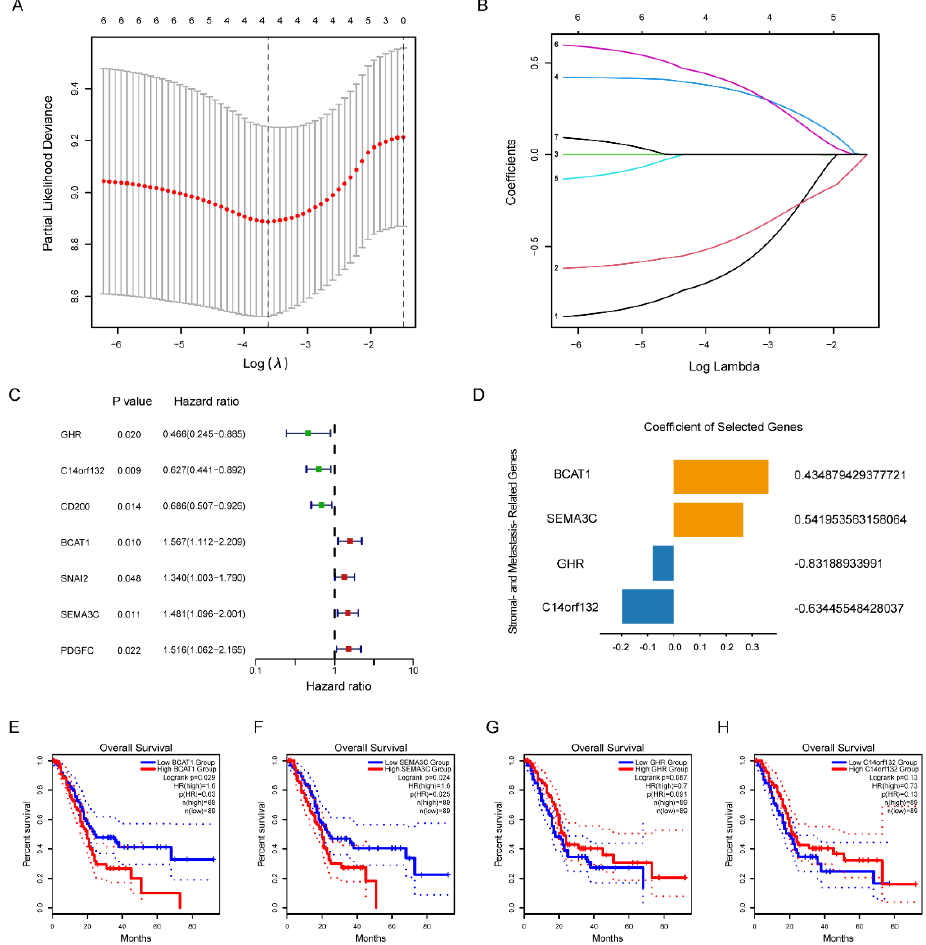
Figure 3. Development of Stroma- and Metastasis-Associated Risk Prognostic Signature. ( A ) Cross- validation plot for penalty term. ( B ) LASSO analysis plot of the stroma- and metastasis-associated genes. ( C ) Forest plot of seven stroma- and metastasis-associated genes. ( D ) Coefficient of the four elected genes. ( E – H ) Kaplan–Meier curves of four stroma- and metastasis-associated genes in TCGA database.